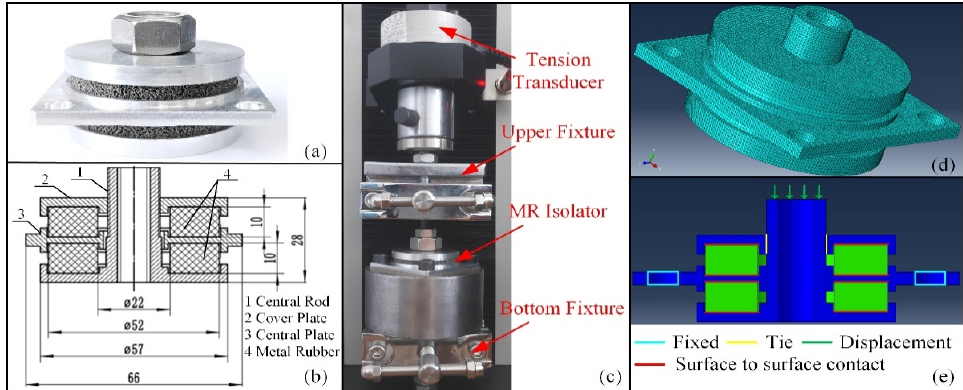
Figure 11. Static experiment and FEM simulation: ( a ) MR isolator, ( b ) assembly diagram of the MR isolator (in millimeter units), ( c ) Static testing equipment, ( d ) FEM model, ( e ) boundary conditions of FEM model.